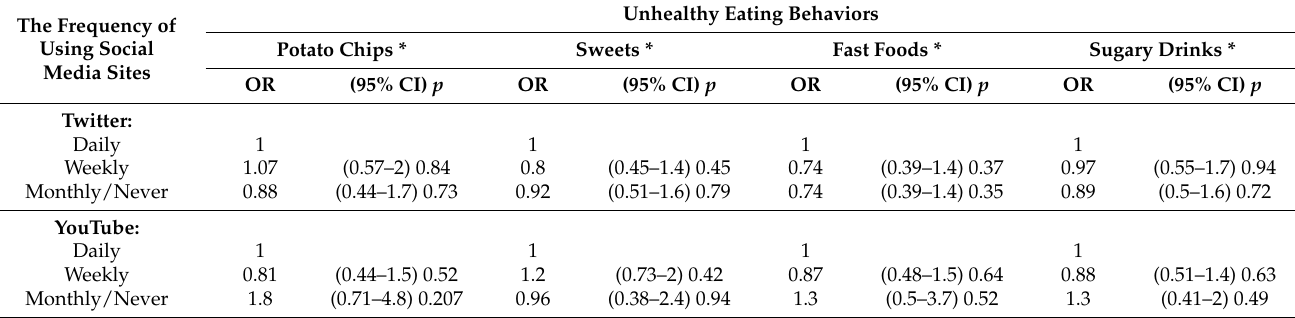
Table 5. Associations between the intake of unhealthy food items and the frequency of using social media